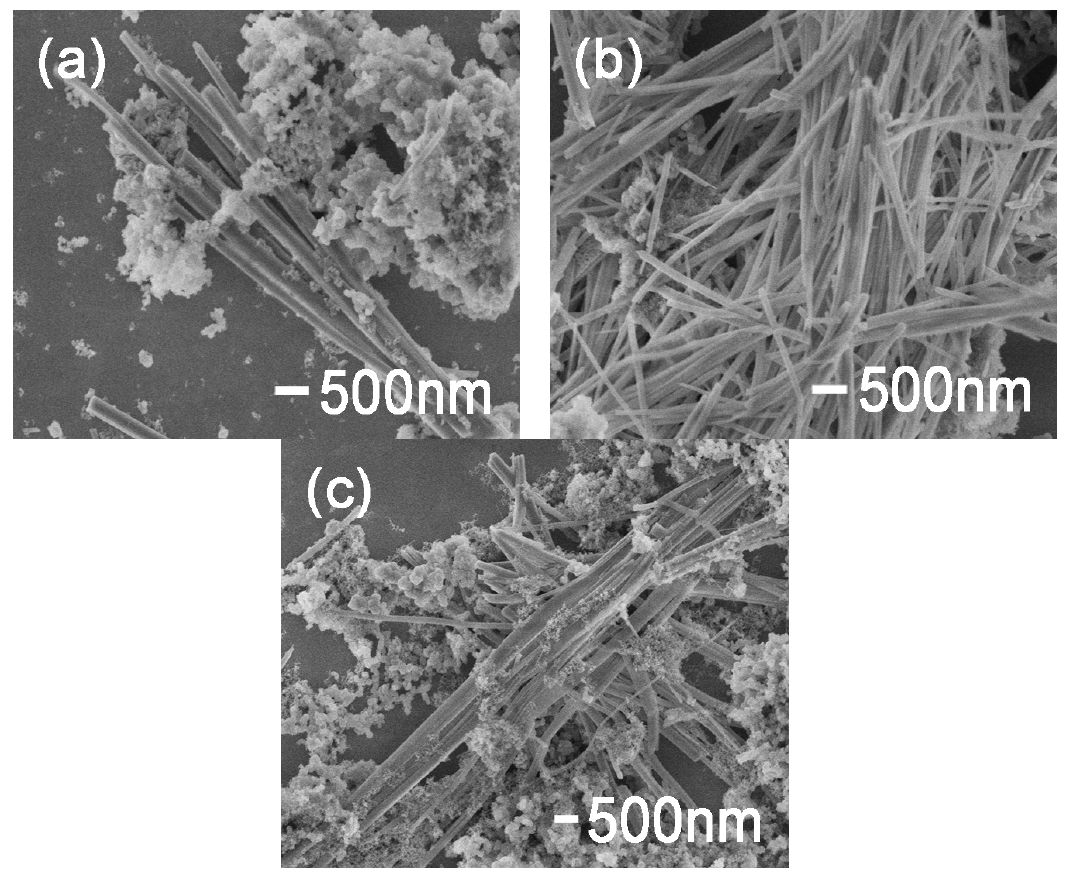
Figure 3. SEM images of Eu 3+ -doped silica samples obtained at different standing times of the solution: ( a ) 10 h; ( b ) 24 h; ( c ) 48 h.